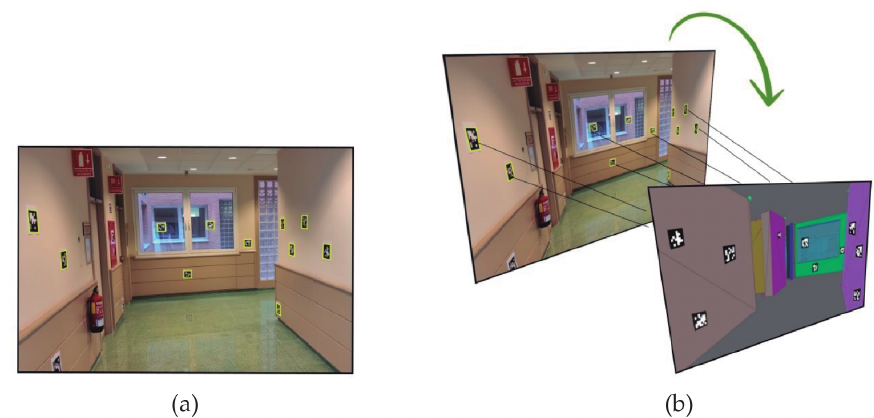
Figure 13. Validation process using fixed markers to validate the user position and orientation: ( a ) marker detection and ( b ) estimation of corresponding anchors in the virtual world.